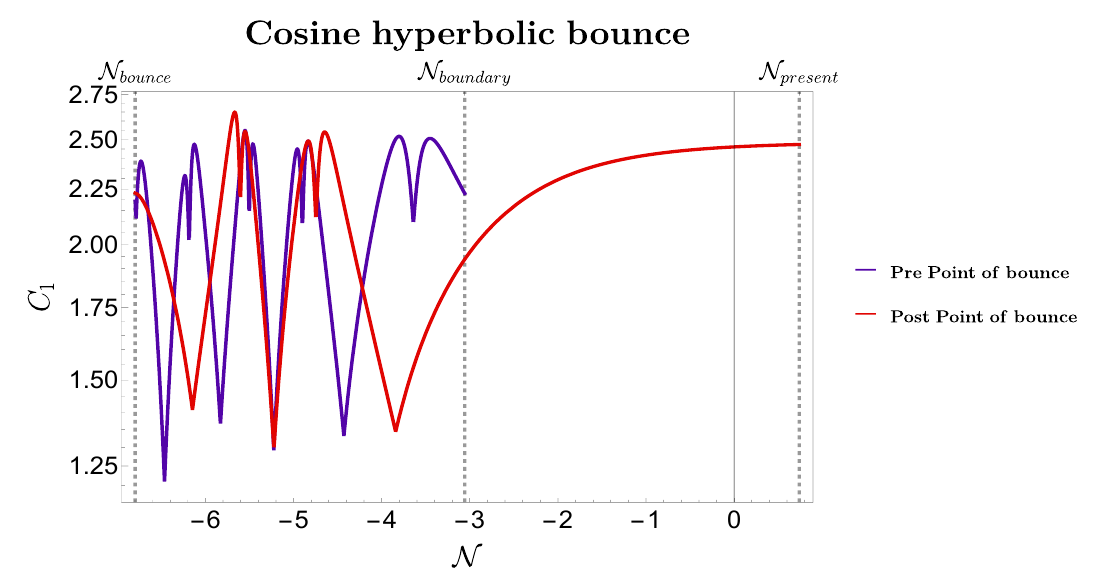
Figure 18: Variation of linearly weighted complexity inside bouncing region with respect to number of e-foldings.